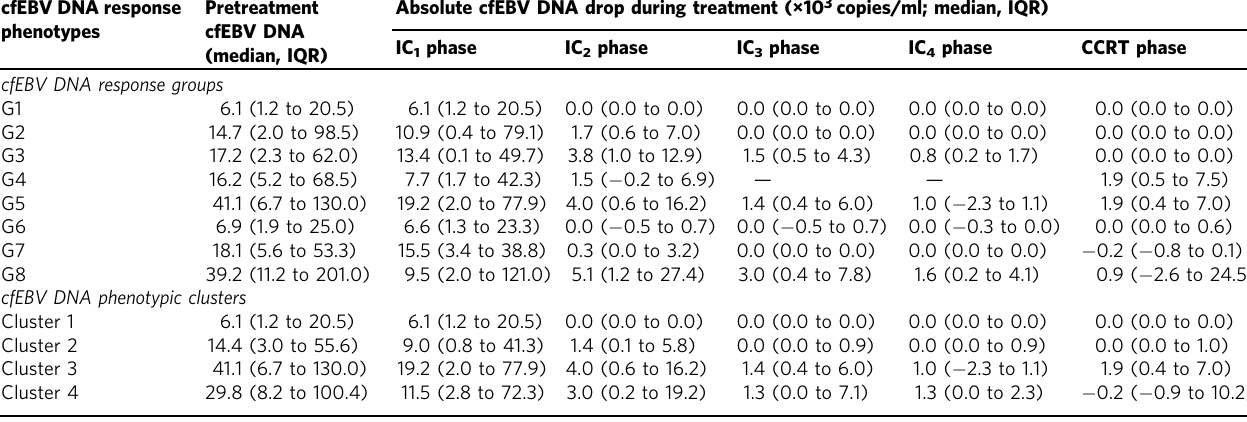
Table 2 Pretreatment cfEBV DNA levels and absolute drop of cfEBV DNA during the course of treatment for the different subgroups cfEBV DNA response Pretreatment phenotypes cfEBV